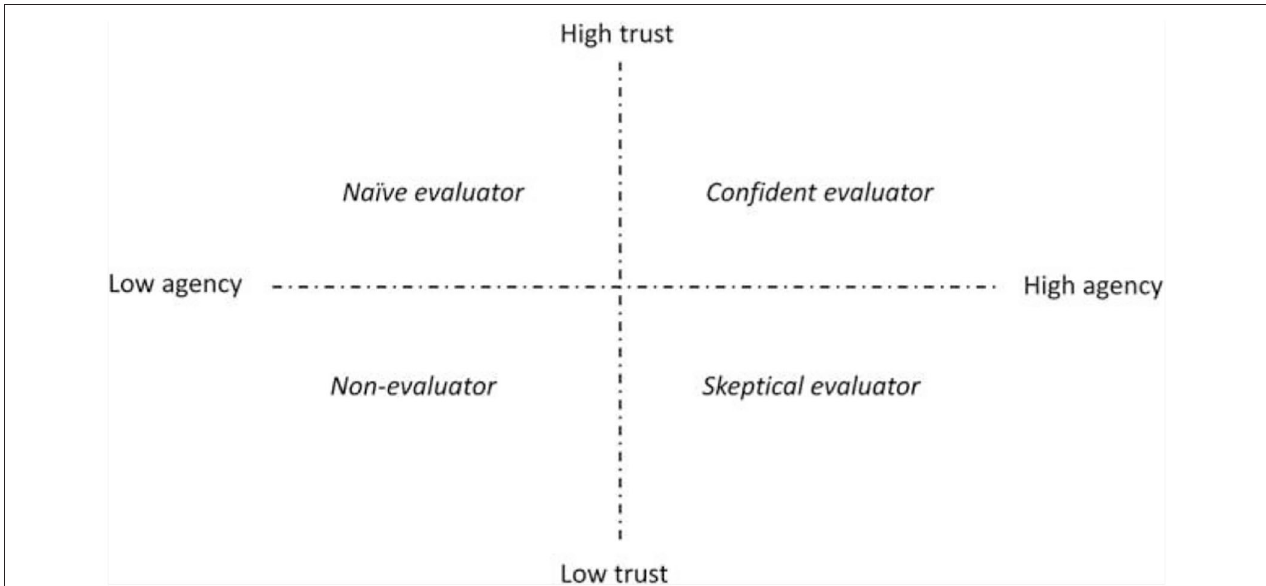
FIGURE 1 | Information assessment stereotypes matrix (Haider and Sundin, 2020: